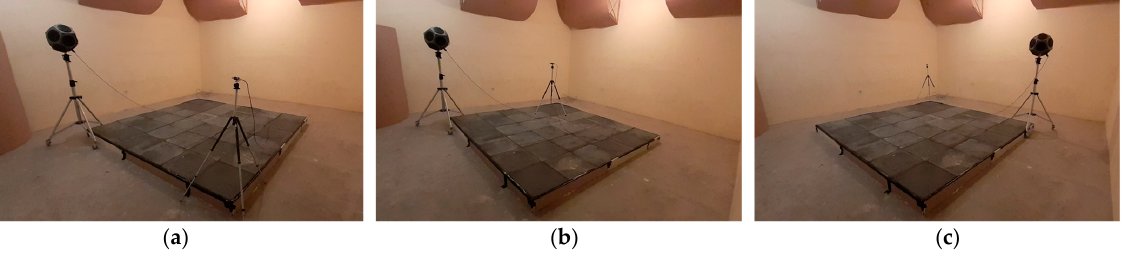
Figure 7. Experimental setup according to ISO 354 [18] with the porous concrete sample placed on the floor of the reverberant room (type A mounting): ( a – c ) different source and microphone posi- tions are observed.